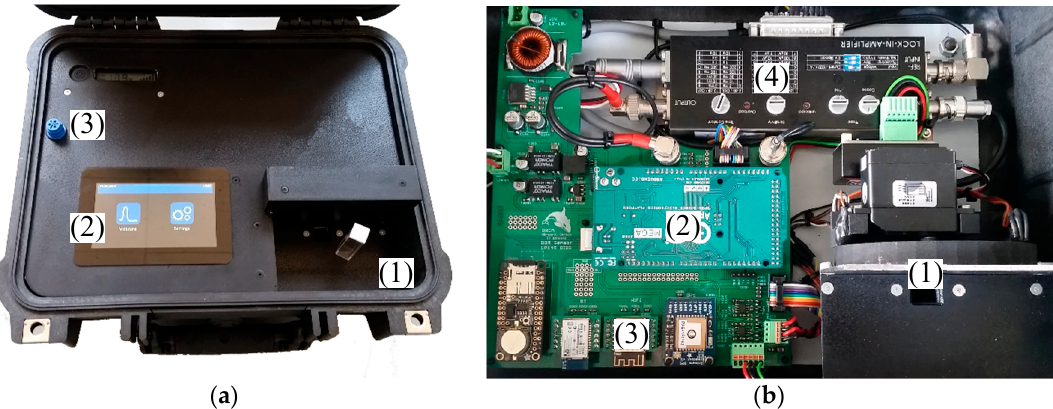
Figure 2. ( a ) Hardware of the sensor prototype with measurement chamber (1), processor board (2), wireless modules (GPS, WIFI, BT) (3) and the lock-in amplifier (4). ( b ) Sensor system ready to use with measurement chamber (1), Touch Display (2) and external power connector (3).